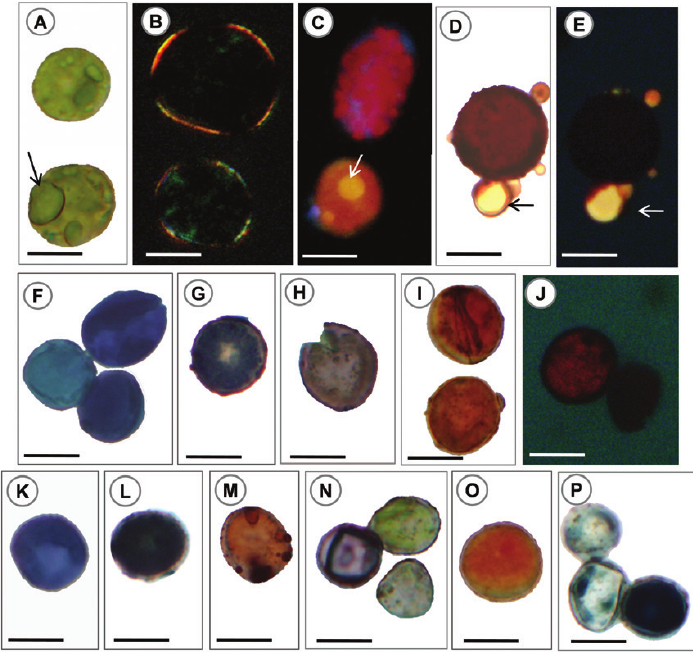
Figure 3 A-P . Histochemical characterization of Neckeropsis undulata spores. A - I . Highland spores. J - P . Lowland spores. A - C . Fresh spores. A, D, F - I, K - P . under white light. B . polarized light. C, E, J . UV light. D, E, J . Staining with Neutral Red. F, K . Staining with Nile Blue. G, L . Staining with Sudan Black B. H, N . Staining with Ruthenium Red . I, O . Staining with Xylidine Ponceau. M . Staining with Sudan IV. P . Staining with Aniline Blue Black. Scale bar: 15